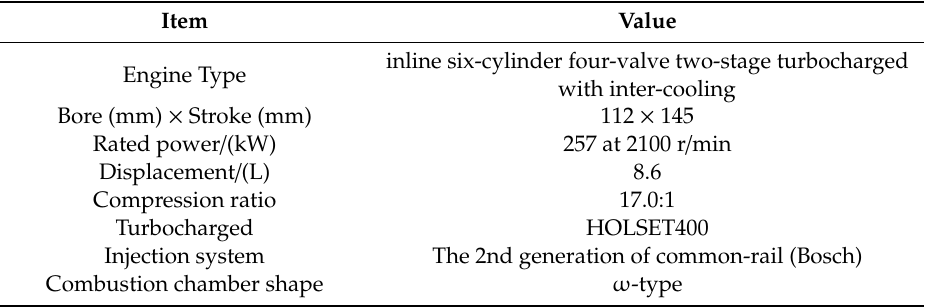
Table 1. Specifications of the basic engine.